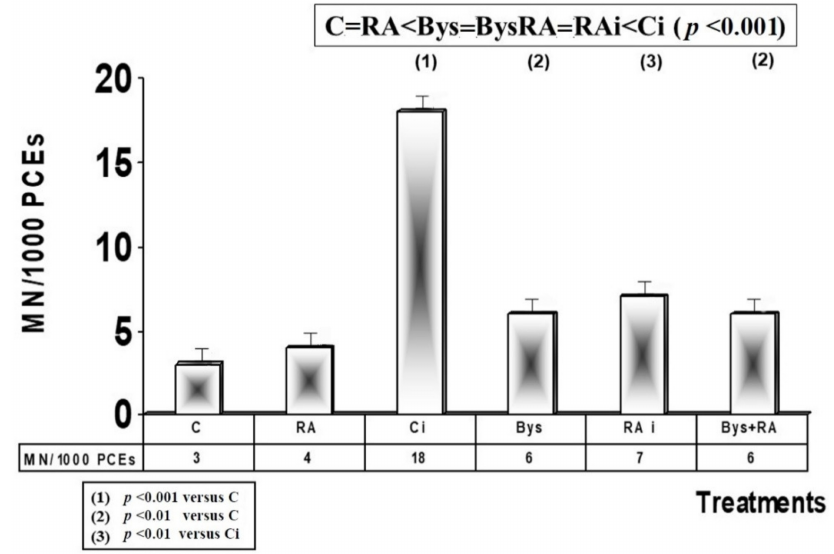
Figure 3. Micronuclei frequency in mouse bone marrow (C, control; RA, treated with rosmarinic acid; Ci, irradiated control; RAi, irradiated, previously treated with rosmarinic acid; Bys, treated with irradiated serum; Bys + RA, treated with irradiated serum, previ- ously treated with rosmarinic